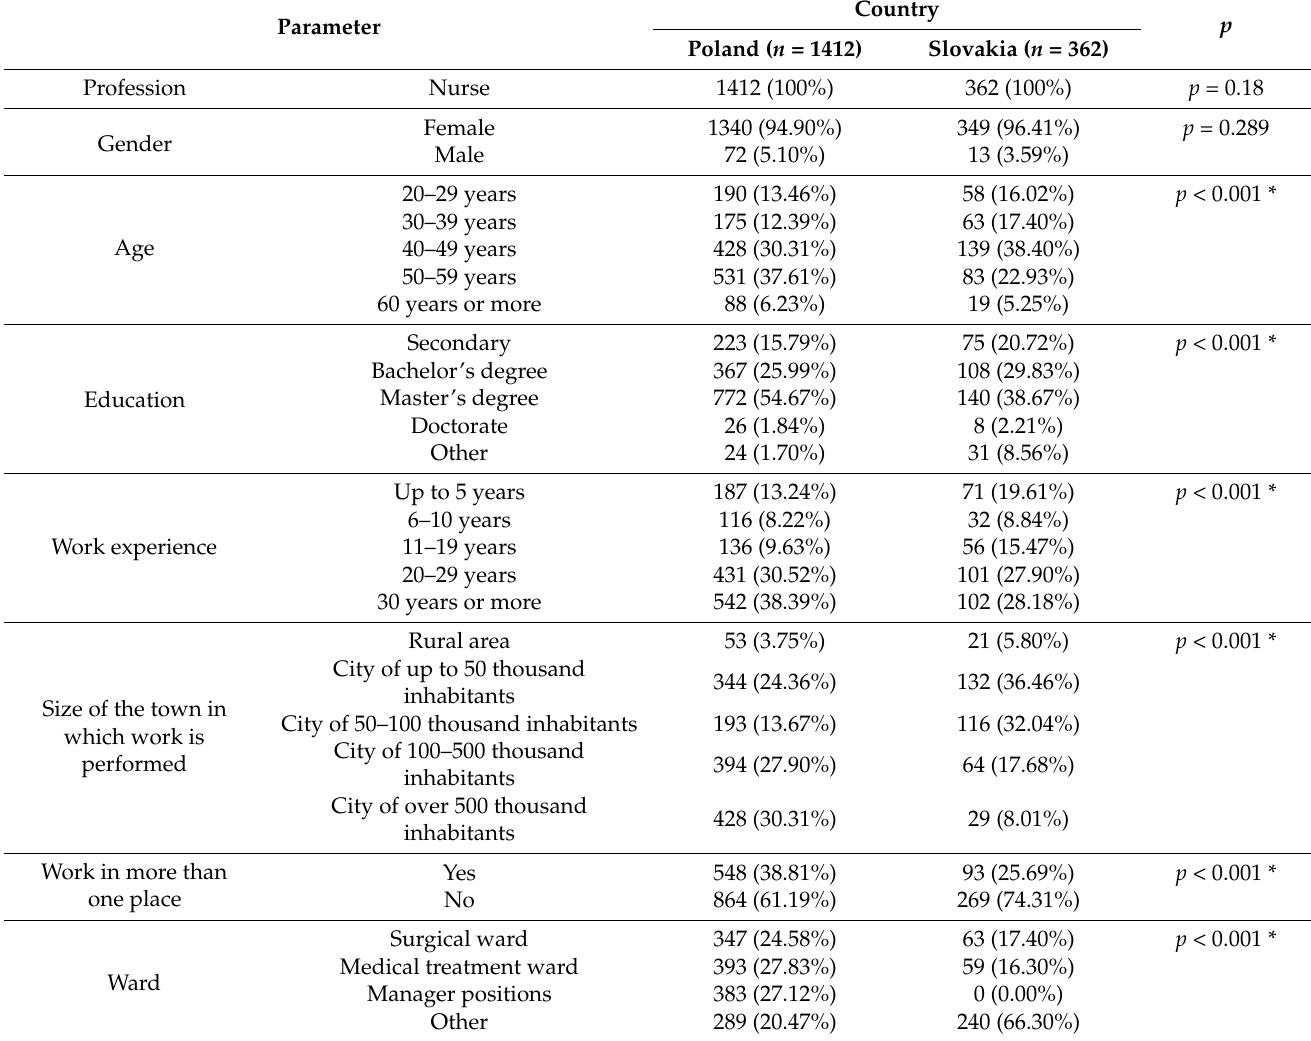
Table 2. Characteristics of the studied group of